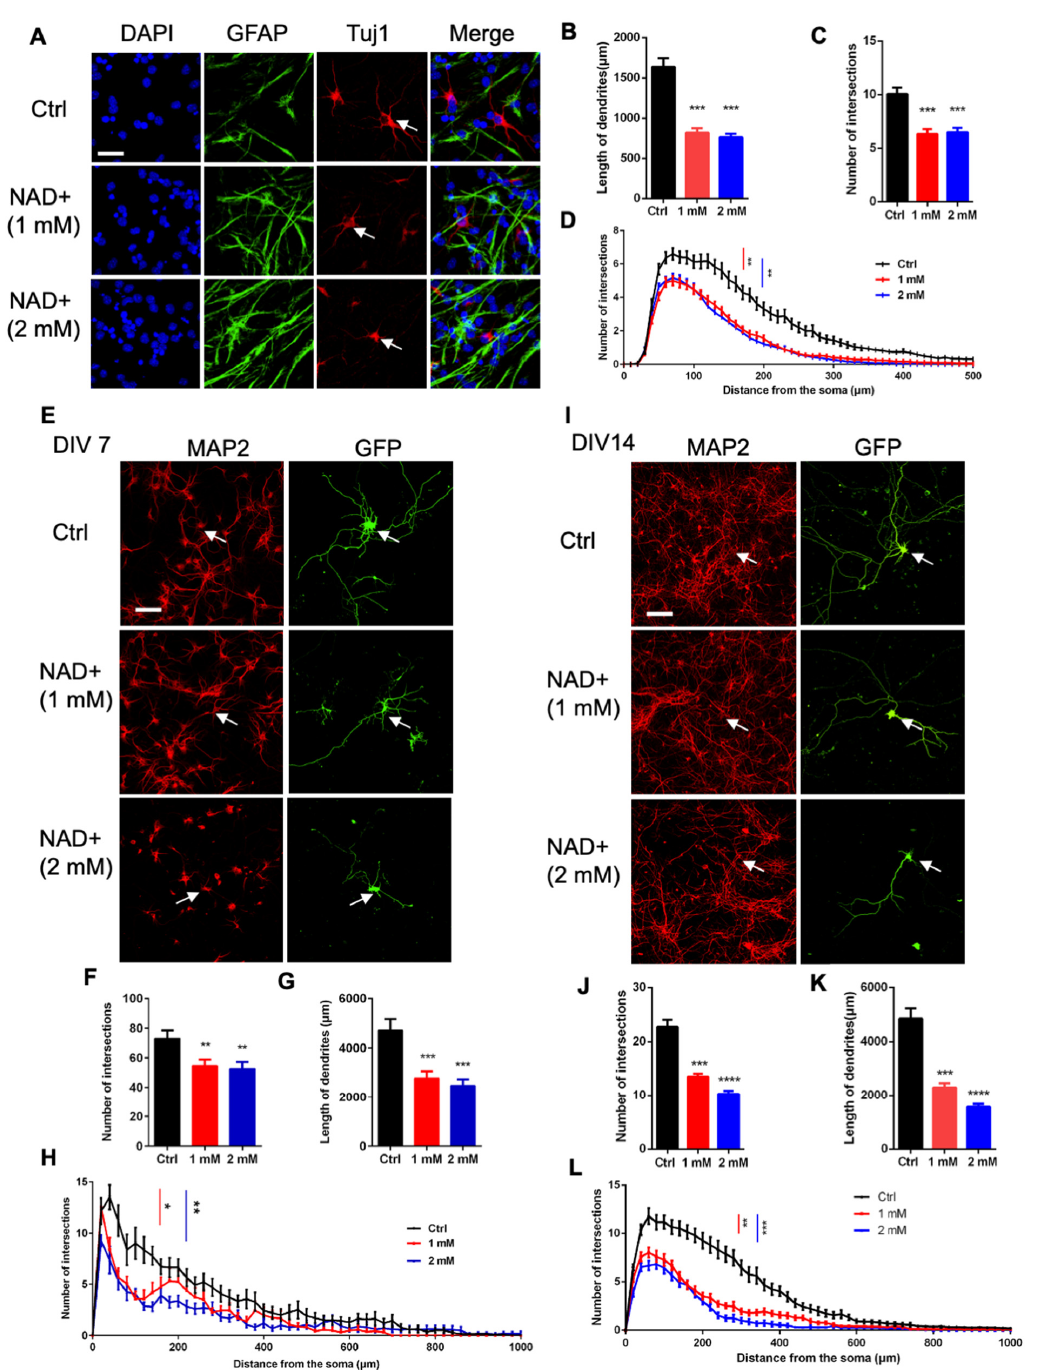
Figure 3. NAD+ exposure inhibits the morphological development of neurons. ( A ) Representative images of Tuj1 immunostaining with Ctrl and NAD+-treated aNSPCs. Scale bar, 50 μ m. ( B , C ) The quantification results show that the NAD+ exposure significantly decreased the dendritic length ( B ) and the intersection number ( C ) of newborn neurons derived from aNSPCs. Data are presented as the mean ± SEM. Unpaired t -test. n = 30 neurons were analyzed in each group. ( D ) Sholl analysis results show that NAD+ exposure reduced the dendritic complexity of aNSPCs-derived neurons